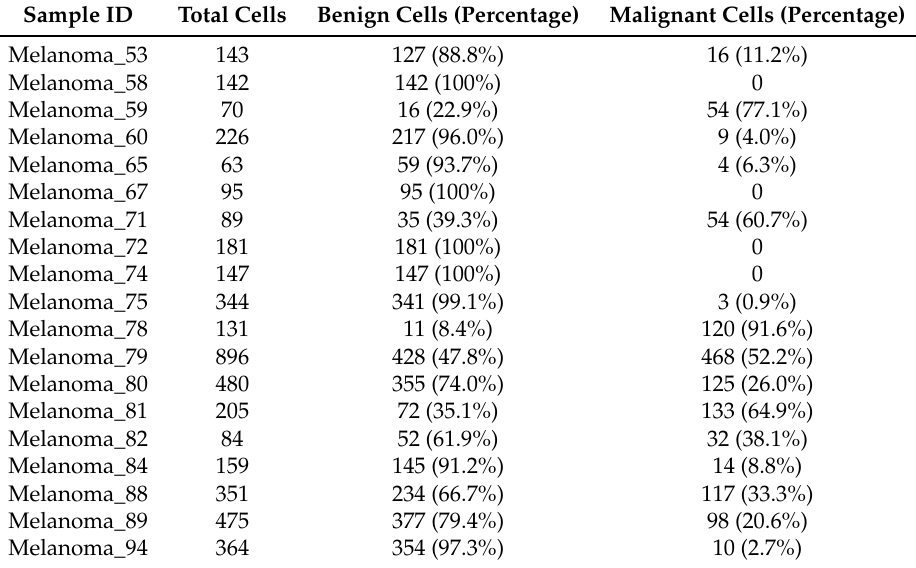
Table 1. Number of cells in each sample/patient.